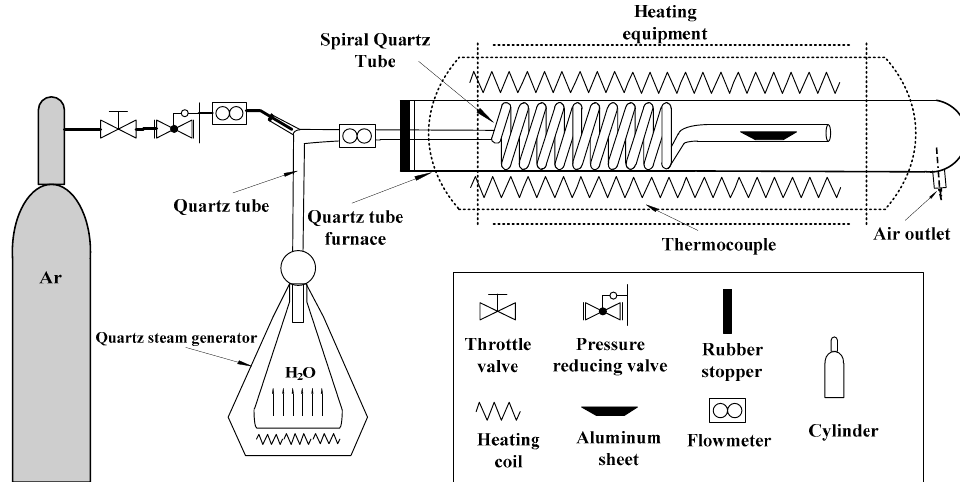
Figure 1. System drawing of the experiment